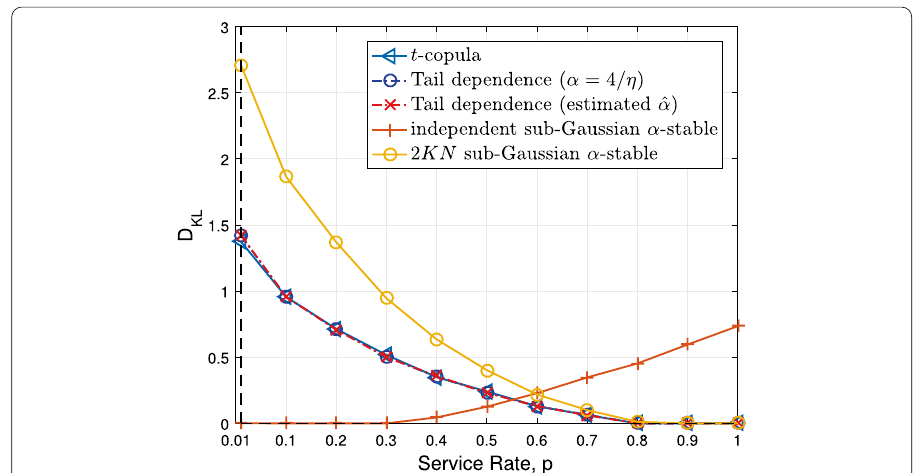
Fig. 5 Plot of the KL divergence between the simulated data set and five statistical models (under HPPP): t ‑copula model (maximum likelihood); Algorithm 1 based on α = 4 /η ; Algorithm 1 based on estimated ˆ α ; independent sub‑Gaussian α ‑stable model; and 4 K sub‑Gaussian α ‑stable model. In the figure, K = 4 msBs and N = 2 subcarriers in each msB are